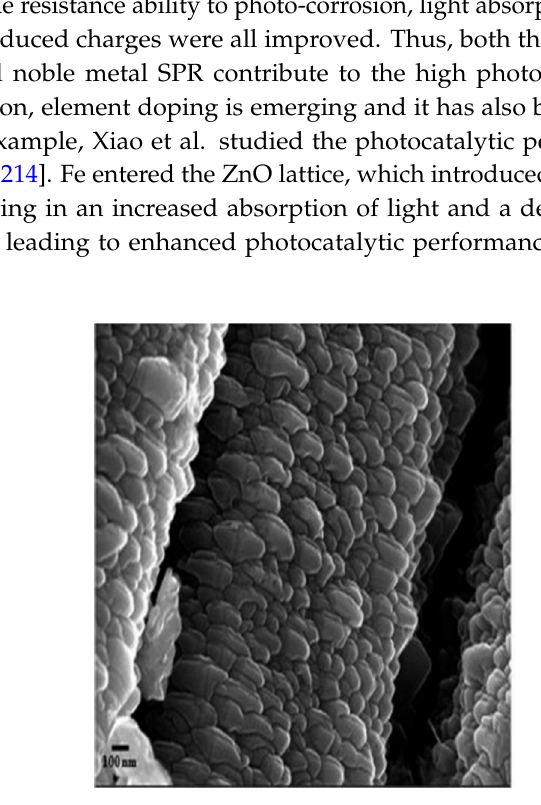
Figure 10. FE-SEM images of ZnO with morphology of nano-corncobs. Reproduced with permission Figure 10. FE ‐ SEM images of ZnO with morphology of nano ‐ corncobs. Reproduced with permission from [211]. Copyright Elsevier, from [211]. Copyright Elsevier, 2015.